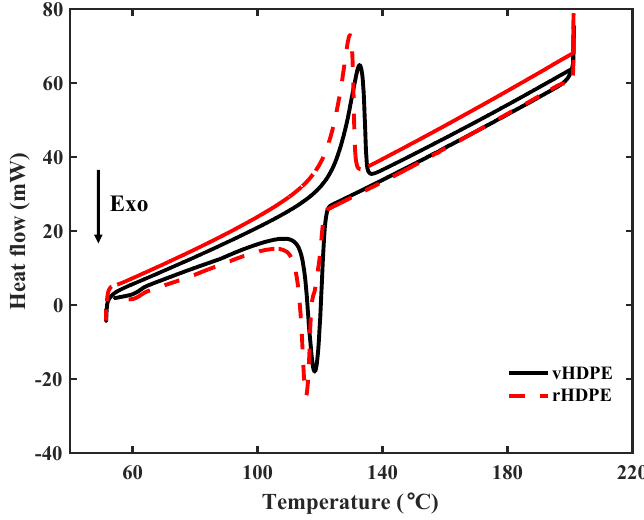
Figure 2. DSC thermograms of vHDPE and rHDPE. Table 1. Melting and crystallization temperatures with their corresponding crystallinity degree and MFI of virgin and recycled